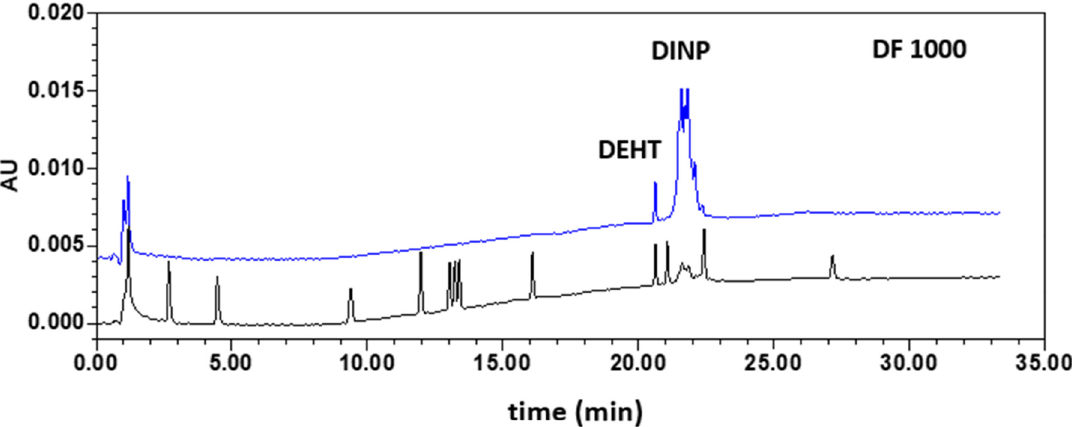
Figure 5. HPLC–DAD chromatograms ( λ = 225 nm) of the calibration standard SC2 (black) and a solution prepared from the V1 glove at a dilution factor of 1000 (blue). DF—dilution factor. Table 4. Amount (%, w/w ) of plasticizers ± standard deviation (three replicates by method) found in five vinyl gloves studied ND: C < LLOQ.